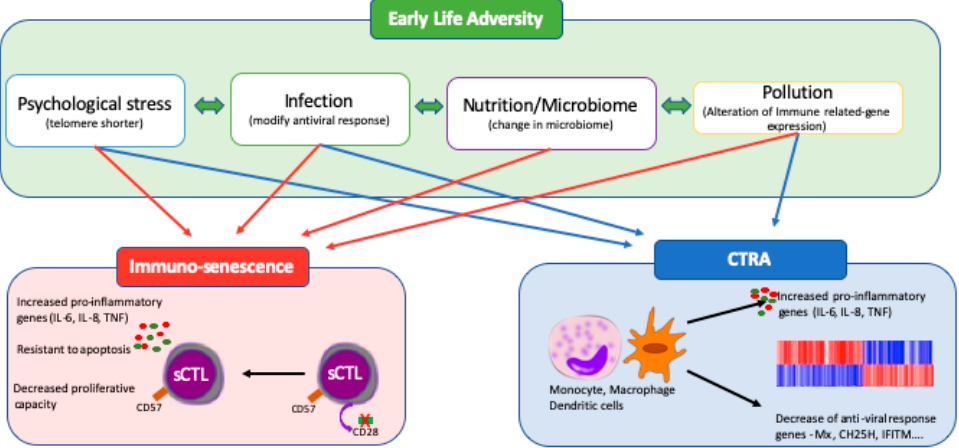
Figure 1. Immune adaptation mediated by early life adversity. Early-life adversity (ELA) is broken down into its four key components: psychosocial stress, infectious stress, nutrition and the microbiome; and pollutant exposure. They are linked to increases in the numbers of senescent cytotoxic lymphocyte (sCTL) which, upon stimulation are resistant to apoptosis and release large quantities of expression of pro-inflammatory. Certain elements have also been shown to alter the underlying transcriptional identity of leucocytes such as macrophages, dendritic cells or T lymphocytes. This phenomenon is called “the conserved transcriptional response to adversity”